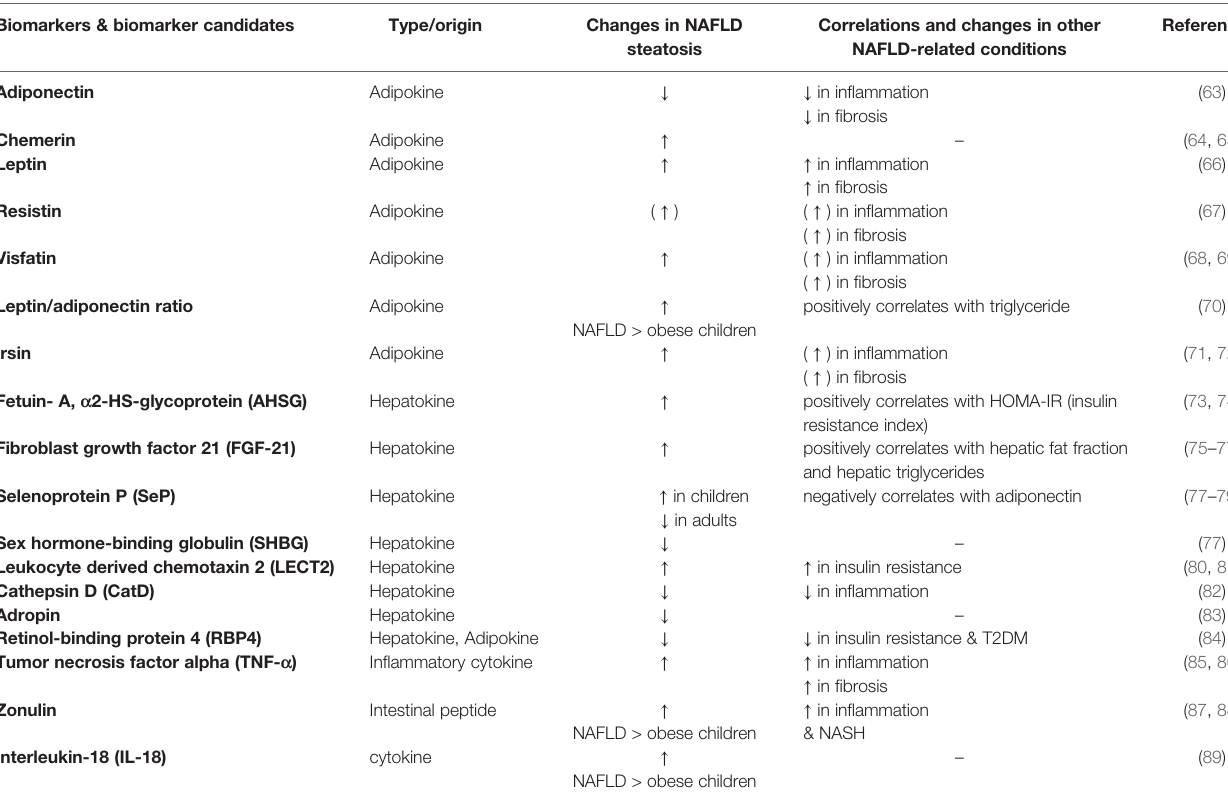
TABLE 1 | Potential Biomarkers for Nonalcoholic Fatty Liver